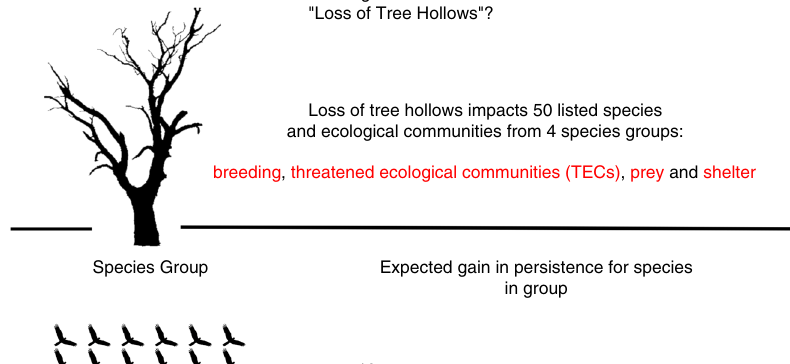
Fig. 3 Interpreting the EVPI analysis for a threat. The graphic shows the results we obtain from our value of information analysis for the threat ‘ Loss of tree hollows ’ . The bar charts in the graphic compare the expected absolute gain in persistence under current uncertainty (EV uncertainty) and the expected gain in persistence if uncertainty was removed (EV certainty). The expected value of removing uncertainty (EVPI) is the difference between EV certainty and EV uncertainty. Values are computed for each affected species group and the average over all species groups affected by the